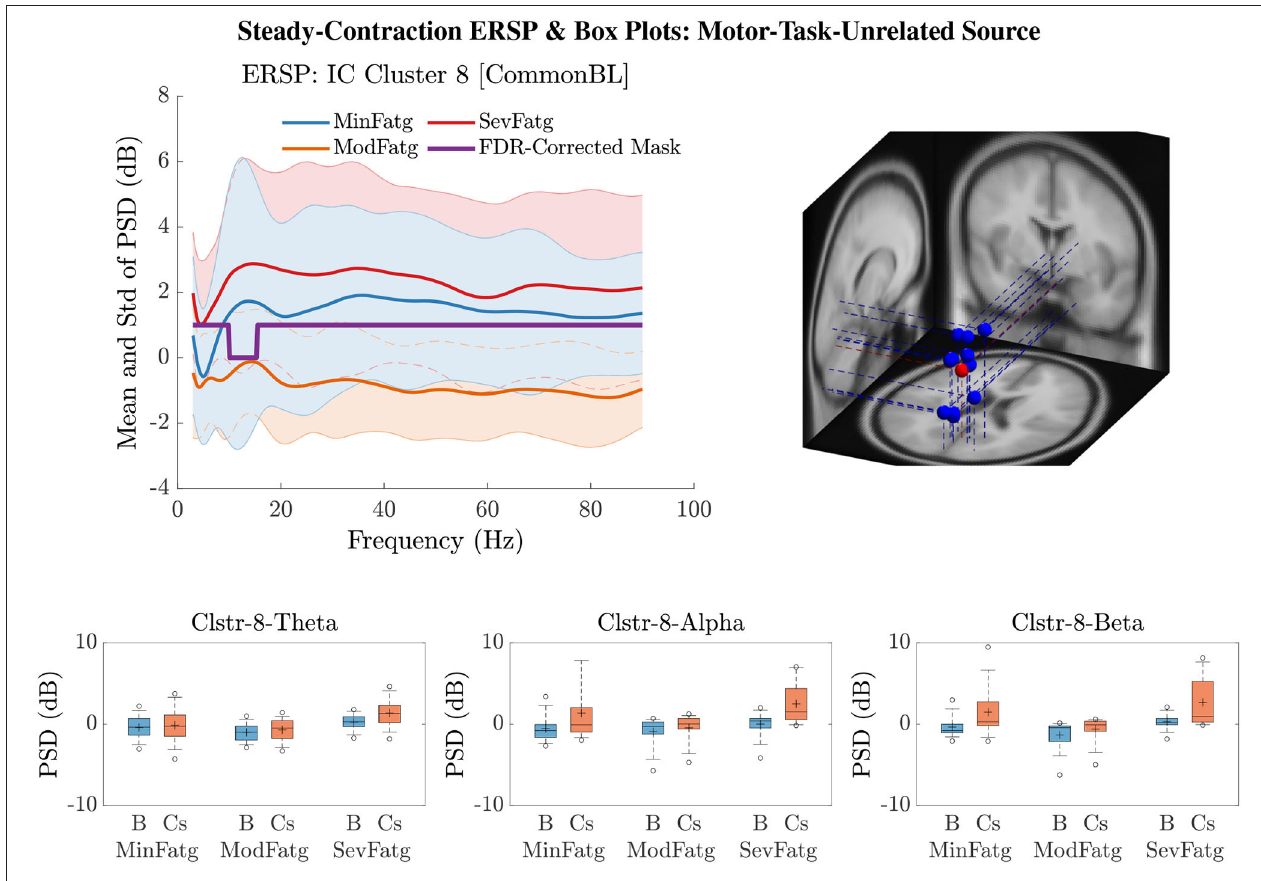
FatgCond FIGURE 12 | ∼ ERSP for IC Cluster 8 computed with the steady-contraction EEG data bears evidence to the fact that the time-averaged PSD fails to scale with the fatigue level throughout the frequency range of interest (row 1: left panel) since the brain source is not located inside a motor-related cortical area (row 1: right panel). The time-averaged band-specific PSD remains disproportional to the fatigue level as can be noted from the box plots of ≈ B theta, alpha, and beta frequency band (row